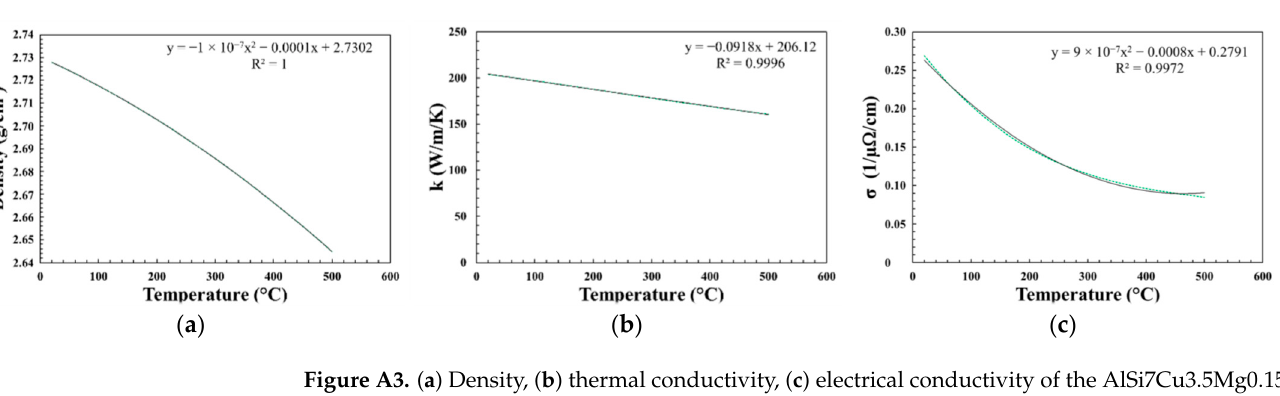
Figure A2. ( a ) Mesh of the system, ( b ) Mechanical parameterization for the quasi- incompressible assembly: pressure contact of 10 7 N/m².